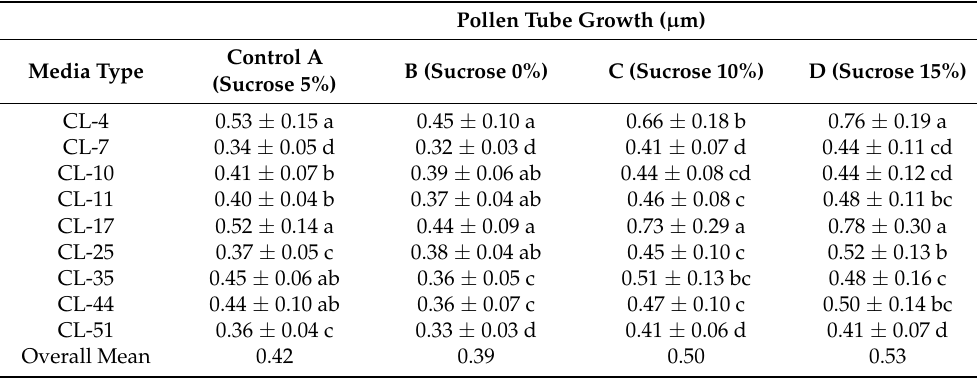
Table 3. Effects of sucrose concentration on pollen tube growth.